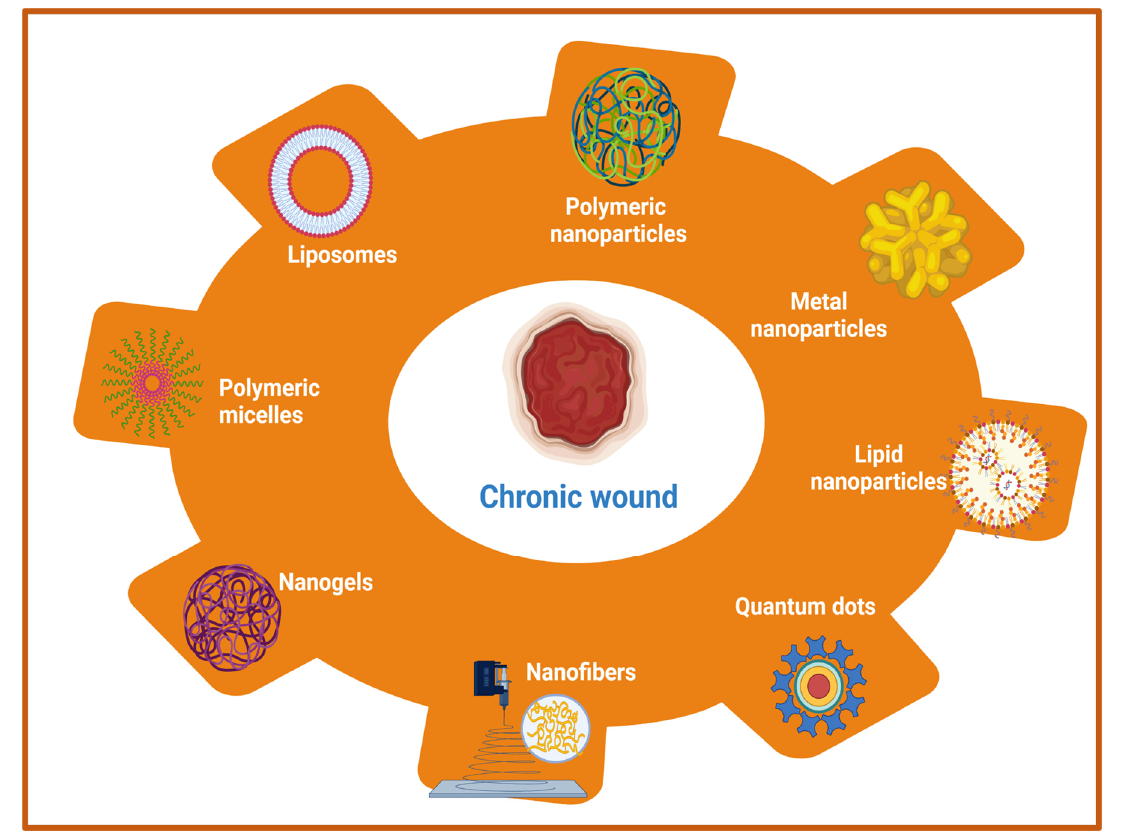
Figure 3. Schematic representation of nanotherapeutic approaches using a wide range of nanomateri- als for chronic wound